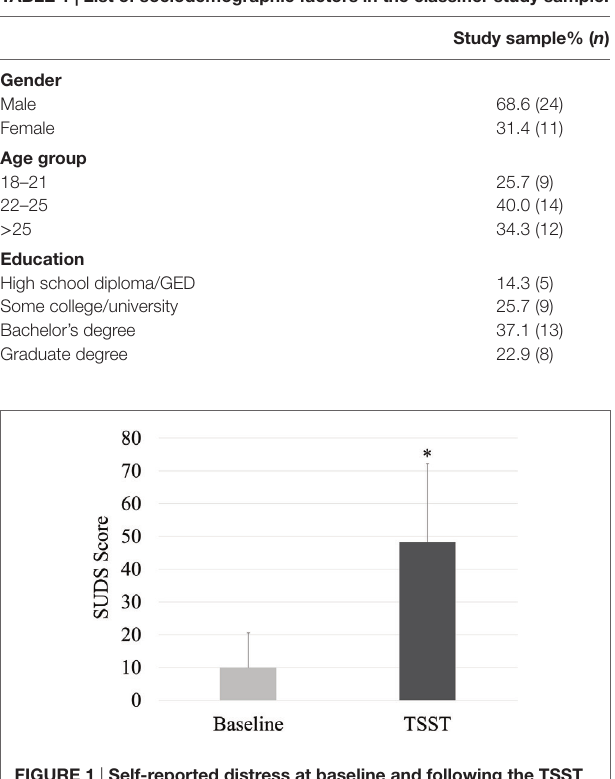
FigUre 1 | self-reported distress at baseline and following the TssT . Mean + SD shown. * p < 0.001.